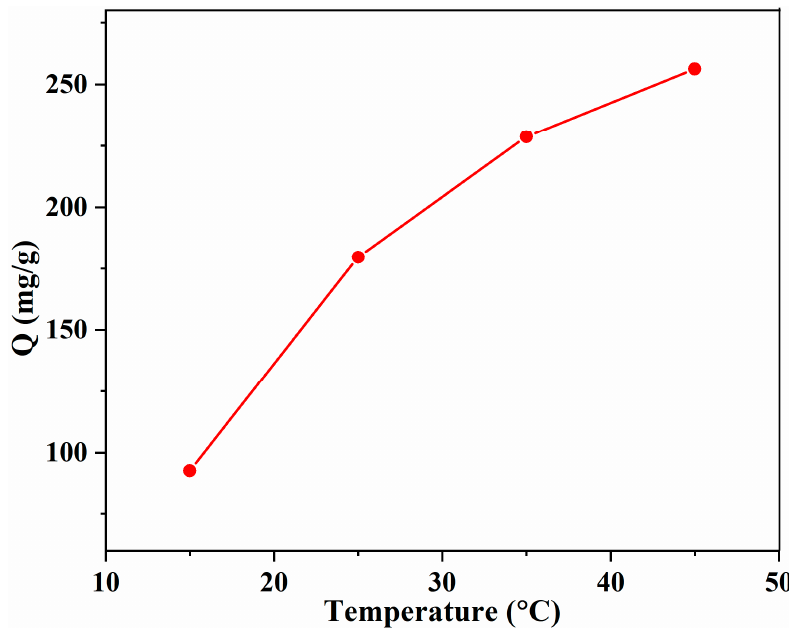
Figure 6. Effect of the temperature on the adsorption capacity with SA/Lig-20% beads ( m = 20 mg, C 0 = 200 mg/L, pH = 12, s = 150 r/min, t = 4 h).